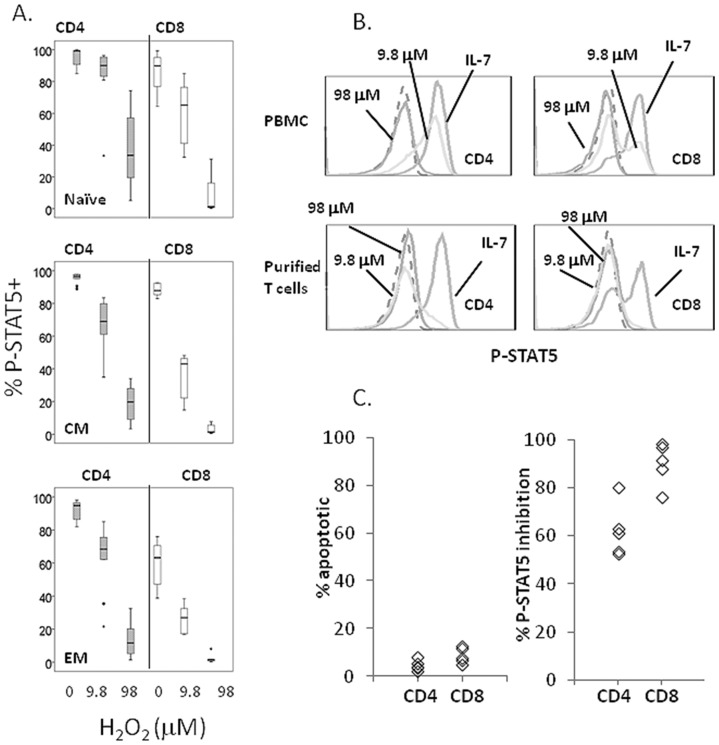
Hydrogen peroxide impairs IL-7 induction of P-STAT5 in T cell subsets.PBMC from healthy control donors were pre-incubated with H2O2 at the indicated concentrations for 30 minutes prior to stimulation with IL-7 (1 ng/ml). The sequential gating strategy included gating on live lymphocytes by forward and side scatter properties, removal of doublets (FSC-A vs FSC-H), gating on CD3+CD4+ cells or CD3+CD8+ cells and then gating on cells based on CD45RA and CD27 co-expression patterns to define subsets. Medians and inter-quartile ranges of P-STAT5+ cells within indicated subsets are represented by box-and-whisker plots for CD4+ T cells (n = 10) and CD8+ T cells (n = 6). Differences between H2O2-treated cells and cells incubated in medium alone were statistically significant at each concentration and for each cell type (p values <0.05). (A) P-STAT5 expression is shown in representative histograms of CD4+ (left column) and CD8+ (right column) T cells from either PBMC cell cultures (top) or purified T cells (>98% purity; bottom). Cells were incubated with H2O2 at the indicated molar concentrations for 30 min. or incubated in medium alone. Cells were then stimulated with IL-7 and assessed for intracellular P-STAT5 expression (1 ng/ml). Dashed histograms represent P-STAT5 expression in unstimulated cells. Data are representative of experiments from 3 different donors (B). PBMC from 5 different donors were used to assess the effects of H2O2 on T cell apoptosis and P-STAT5 induction. The percentages of total apoptotic CD4+ and CD8+ T cells were determined by annexin V staining during culture of PBMC with 98 µM H2O2. These percentages are compared to the percent inhibition of P-STAT5 signaling in PBMC that was observed after stimulation with IL-7 in the presence of 98 µM H2O2 (C). Note that the proportions of cells that show evidence of apoptosis are far lower than the proportions of cells with impaired P-STAT5 induction.